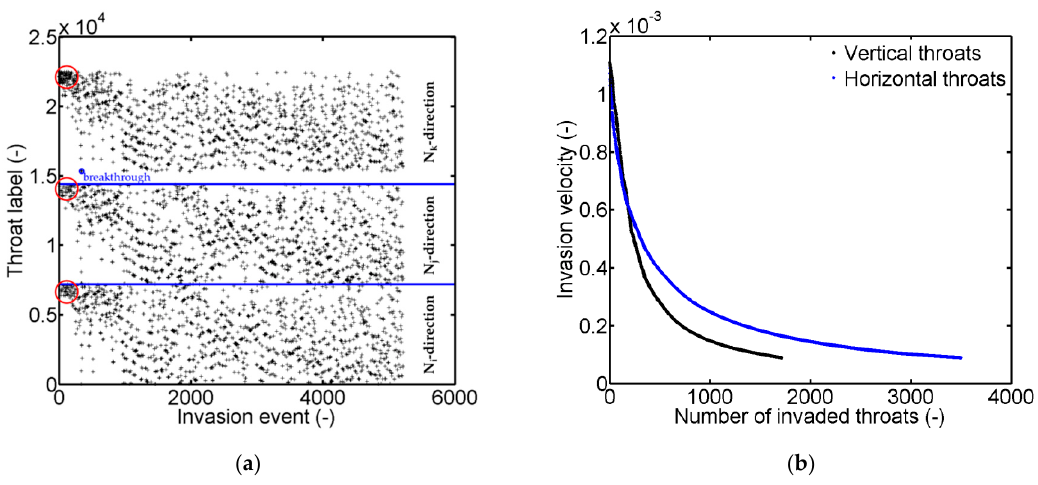
Figure 13. ( a ) Order of invasion on the example of the PN discussed above. According to Figure 1, higher throat labels are associated with the top side of the PN. ( b ) Invasion velocities in vertical and horizontal direction.